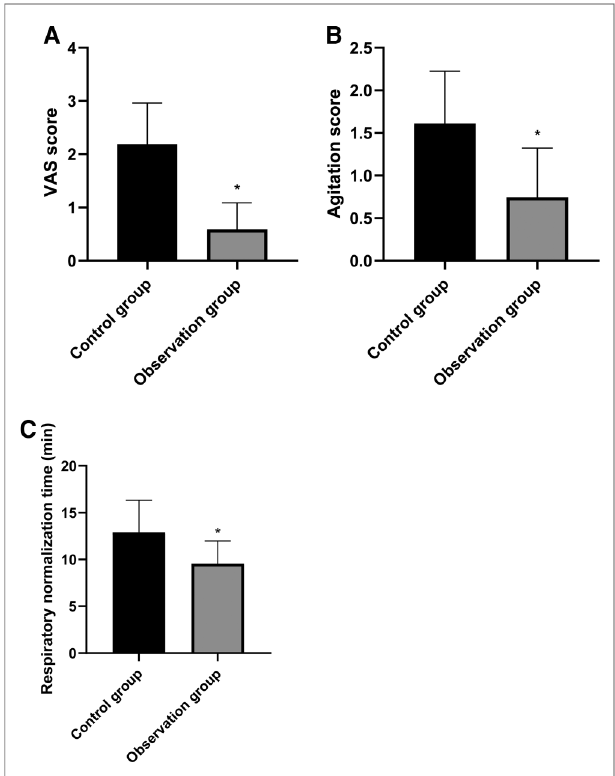
FIGURE 1 | Comparison of anesthesia effects between two groups. Note: Compared with the control group, * p